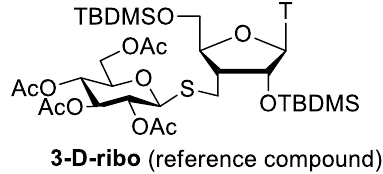
Table 2. Characteristic 1 H and 13 C NMR peaks (ppm) and 3 J H,H values (Hz) of compounds 8 – 18 and reference compounds 3 and 3- d -ribo .